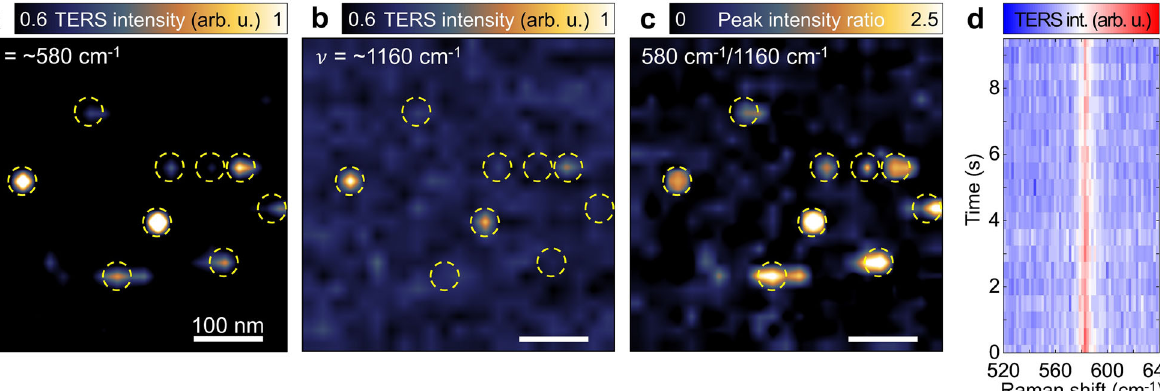
Fig. 3 Single-molecule level TERS images and effect of the Al 2 O 3 capping layer. TERS mapping images of single BCB molecules measured with the excitation laser power of 220 μ W and acquisition time of 0.5 s at each pixel at room temperature. TERS peak intensity images for in-plane symmetric stretching mode of O-C 2 and N-C 2 observed at ~580 cm − 1 ( a ) and in-plane asymmetric stretching mode of O-C 2 observed at ~1160 cm − 1 ( b ). c TERS peak- to-peak intensity ratio image of ~580 cm − 1 and ~1160 cm − 1 peaks, arithmetically calculated from TERS images a and b after subtracting a background fl uorescence signal. Yellow dashed circles in a – c indicate the same positions in the TERS images. d Time-series TERS spectra at a single fi xed position. Source data are provided as a Source Data fi le.